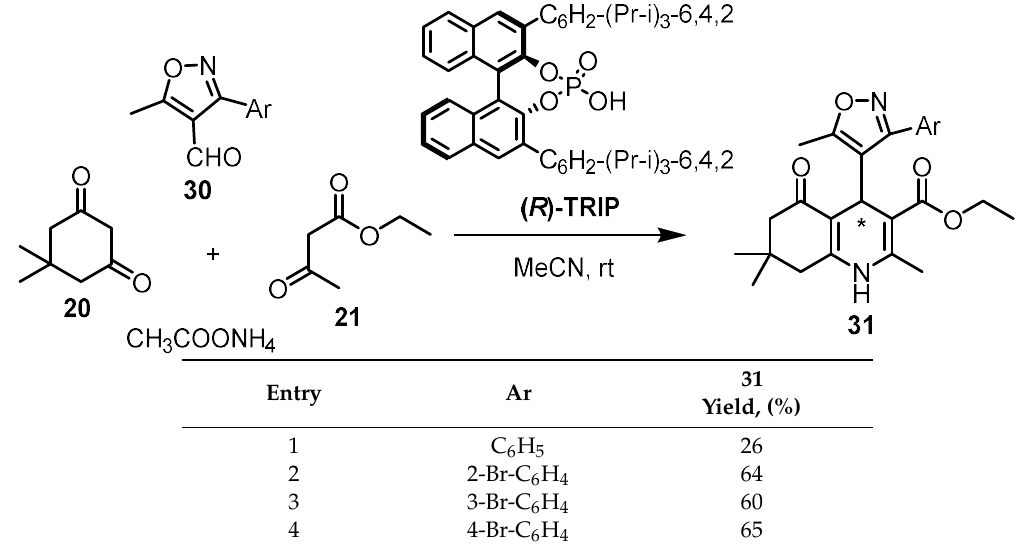
Table 11. ( R )-TRIP catalysed synthesis of fused 1,4-DHPs 31